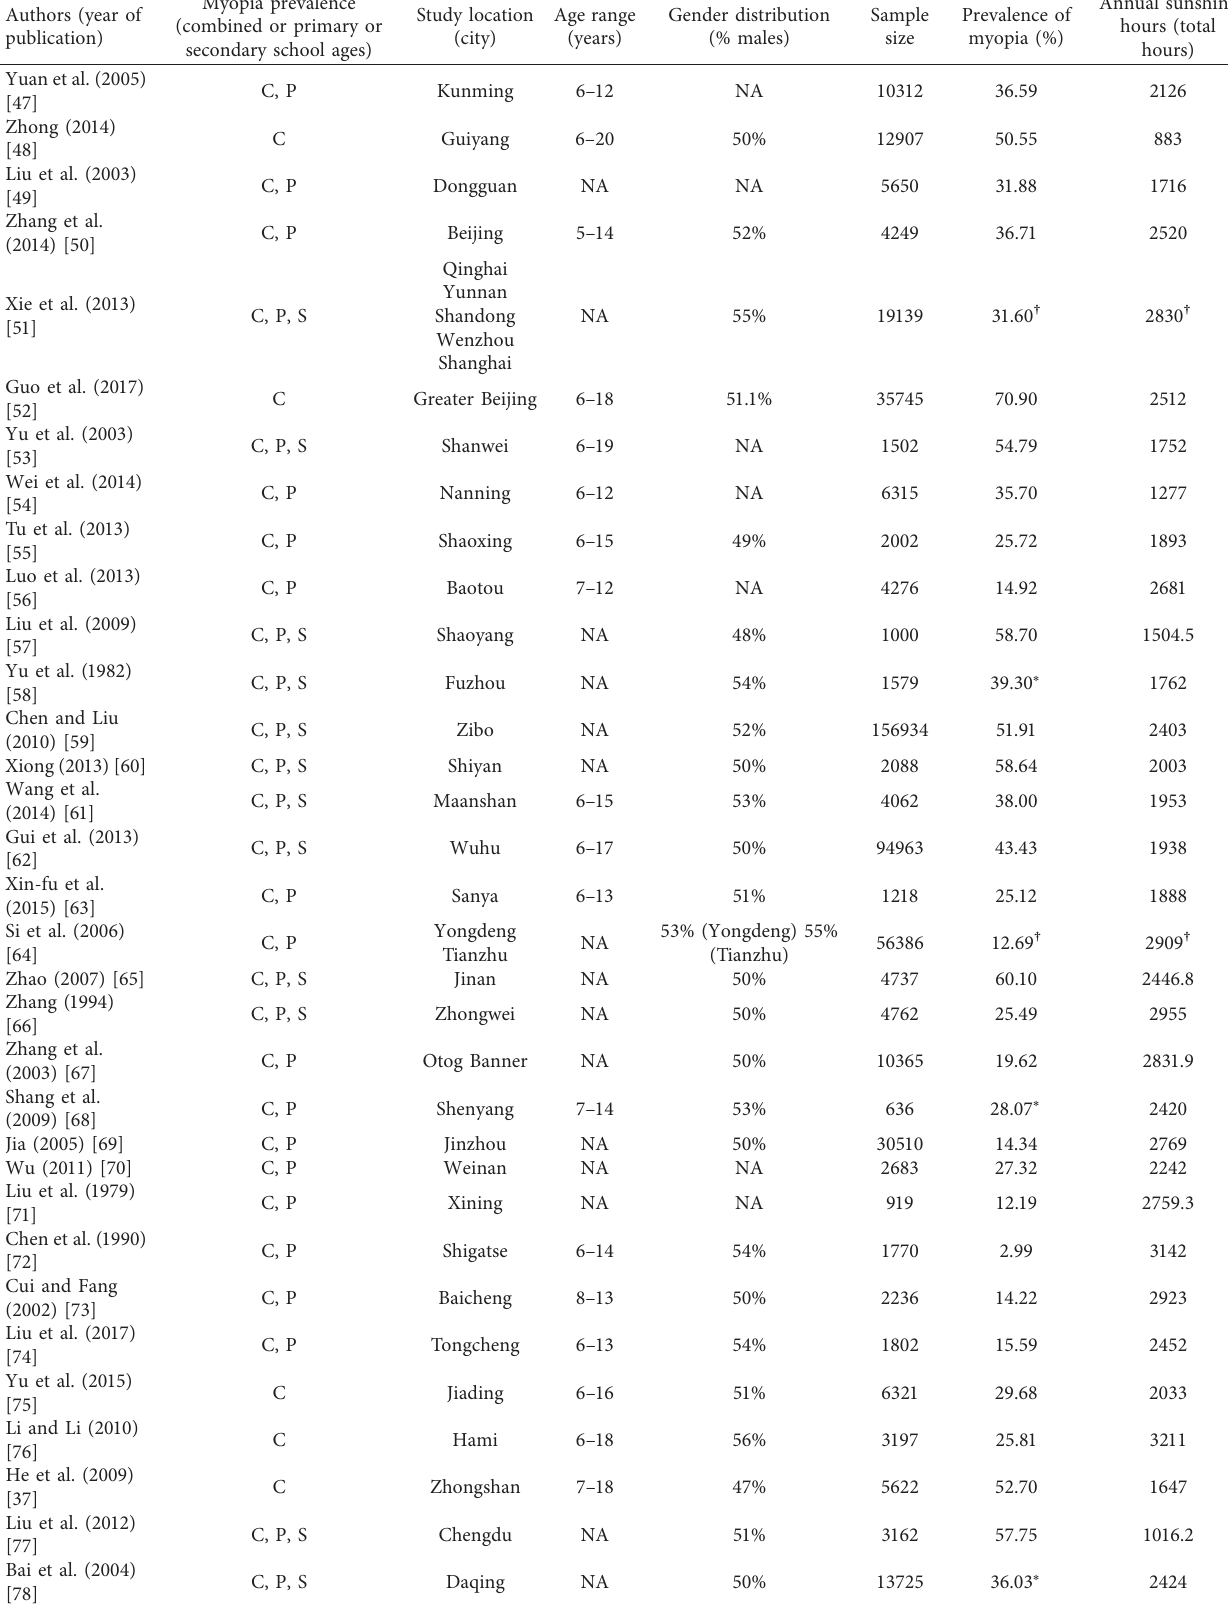
Table 1: Characteristics of all the studies included in the